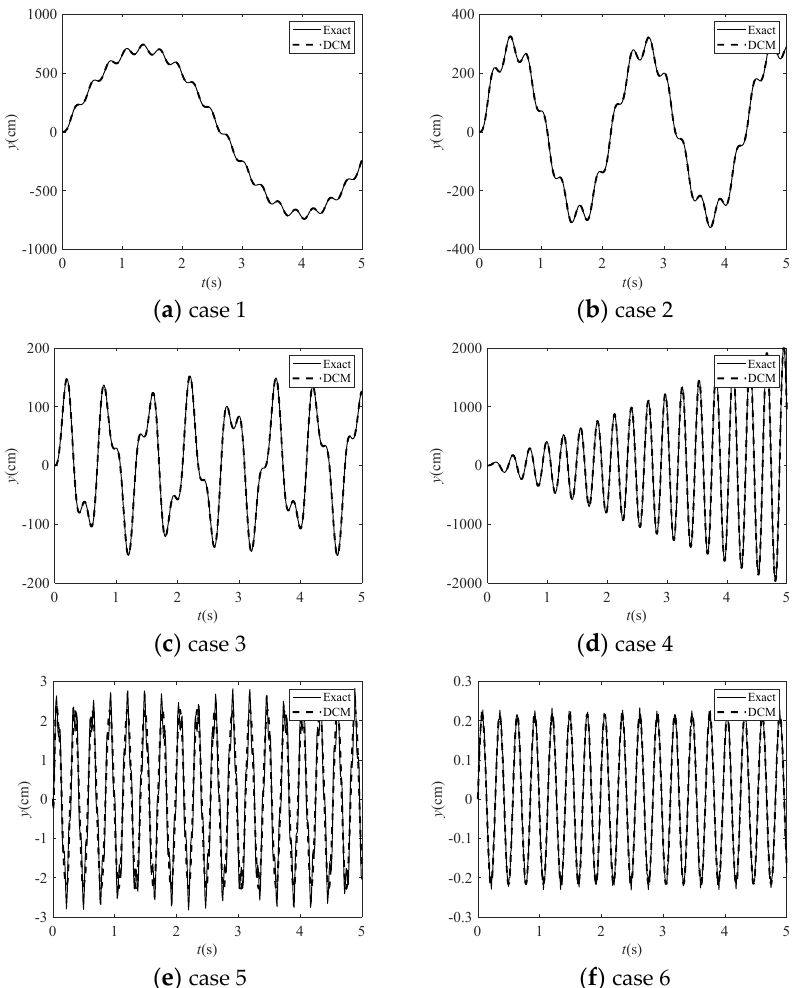
Figure 9. Time-history displacement of beam midpoint under forced vibration.